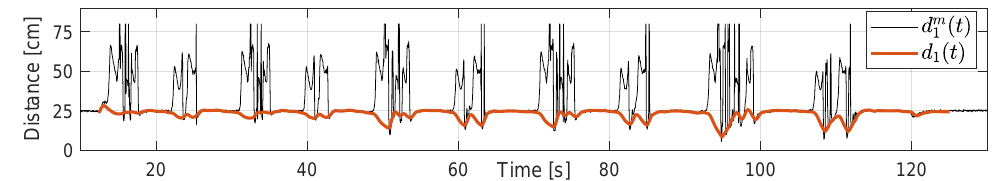
Figure 7. Offline video-based distance measurement